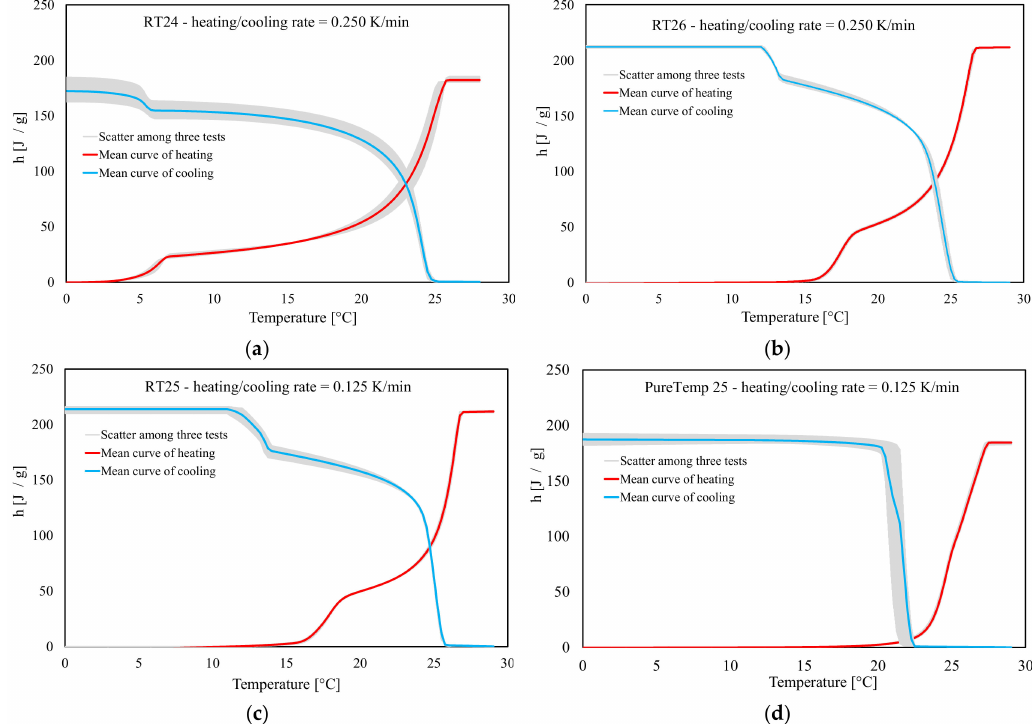
Figure 12. Enthalpy (latent-only) measurements (heating and cooling) following the dynamic DSC